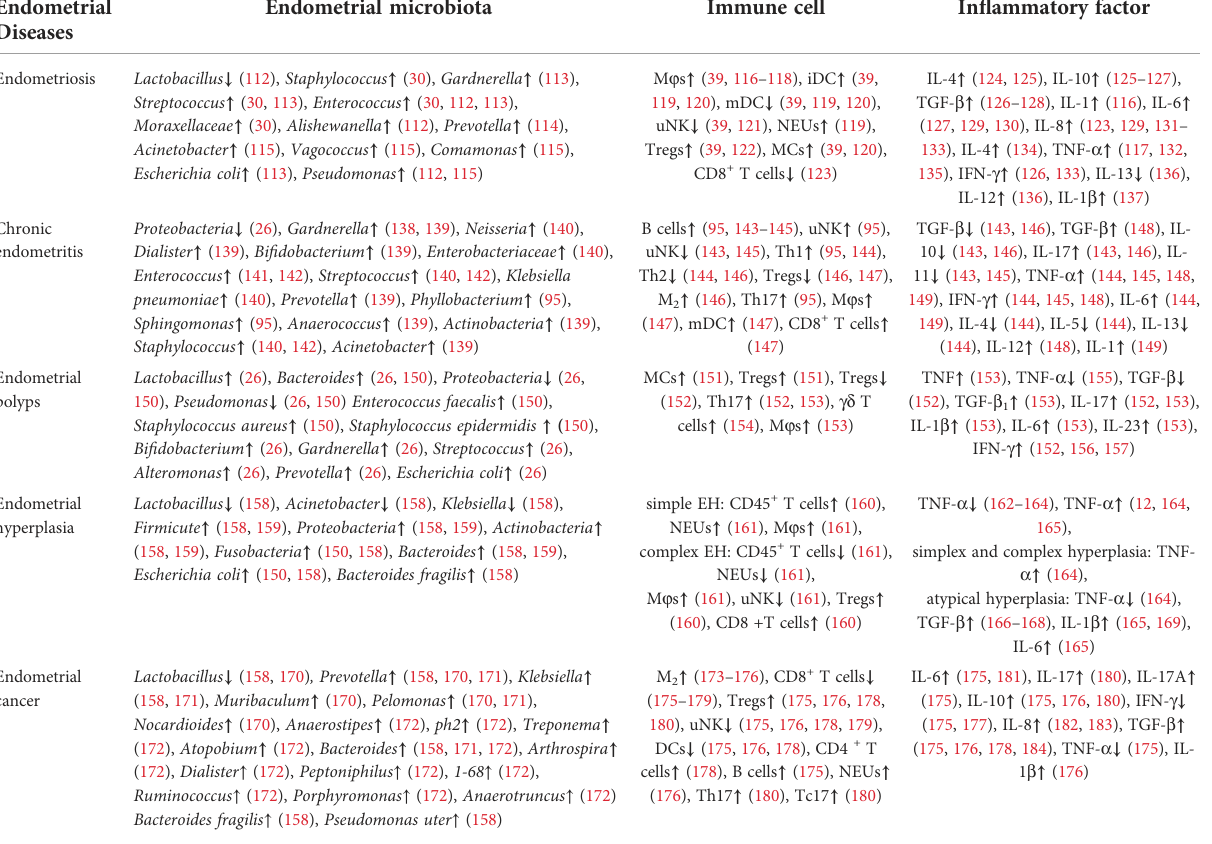
TABLE 1 Endometrial microbiota composition and immune response in different endometrial disease. Endometrial